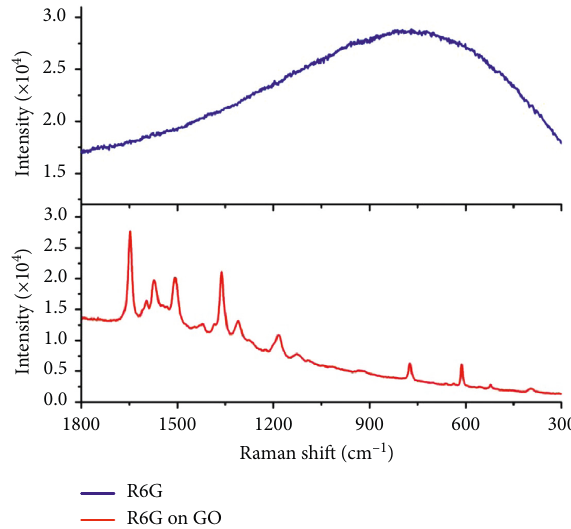
Figure 4: Raman spectra of R6G drop casted on the surface of Si wafer and GO. The inset displays the structure of R6G.